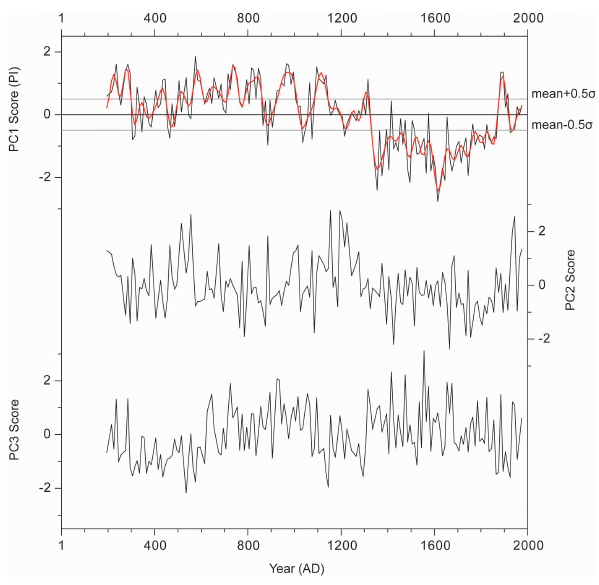
Fig. 3. Principal Component Analysis results. PC1 was defined as precipitation index (PI) to represent synthesized precipitation record for north central China. The red line is the record after 50-year low pass FFT filter.